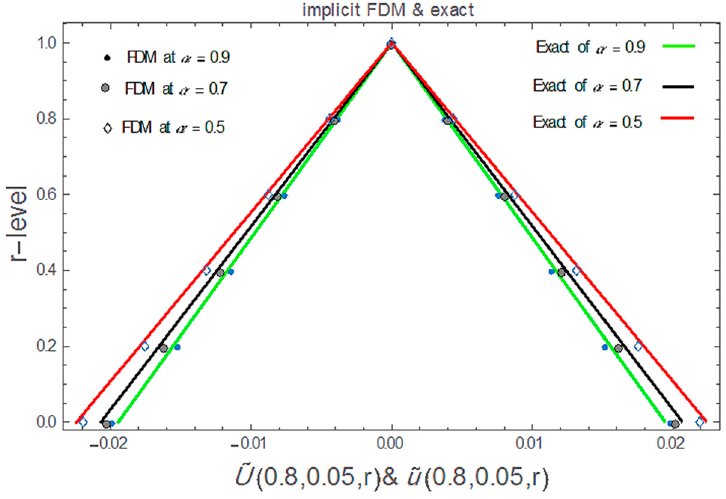
Figure 4. Exact and explicit FDM of the solution of Equation (30) at different values of α for all 𝑟 ∈ [0,1].